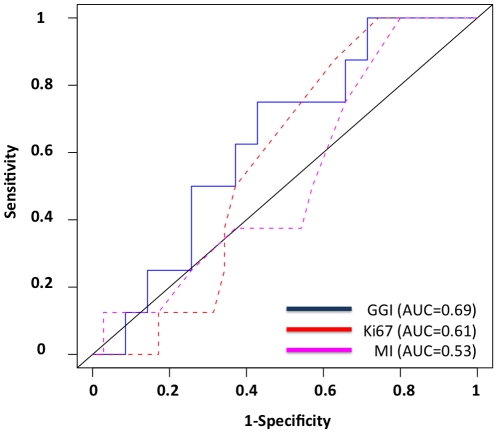
Prediction of metastases events at 10 years of follow-up from initial diagnosis.Receiver Operating Curves. 43 Histological Grade II, ER positive samples with 10-year follow-up data. Blue: Genomic Grade Index; Red: Ki67; Pink: Mitotic Index.